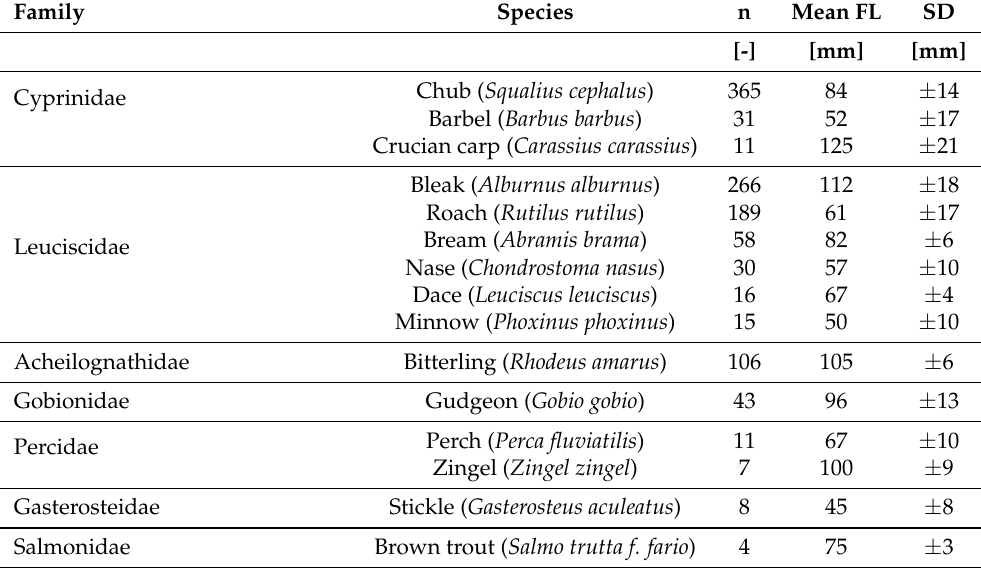
Table 1. Fish in the ethohydraulic experiments, number of participating individuals (n), mean fork length (FL) (mm) and standard deviation (SD) of mean fork length